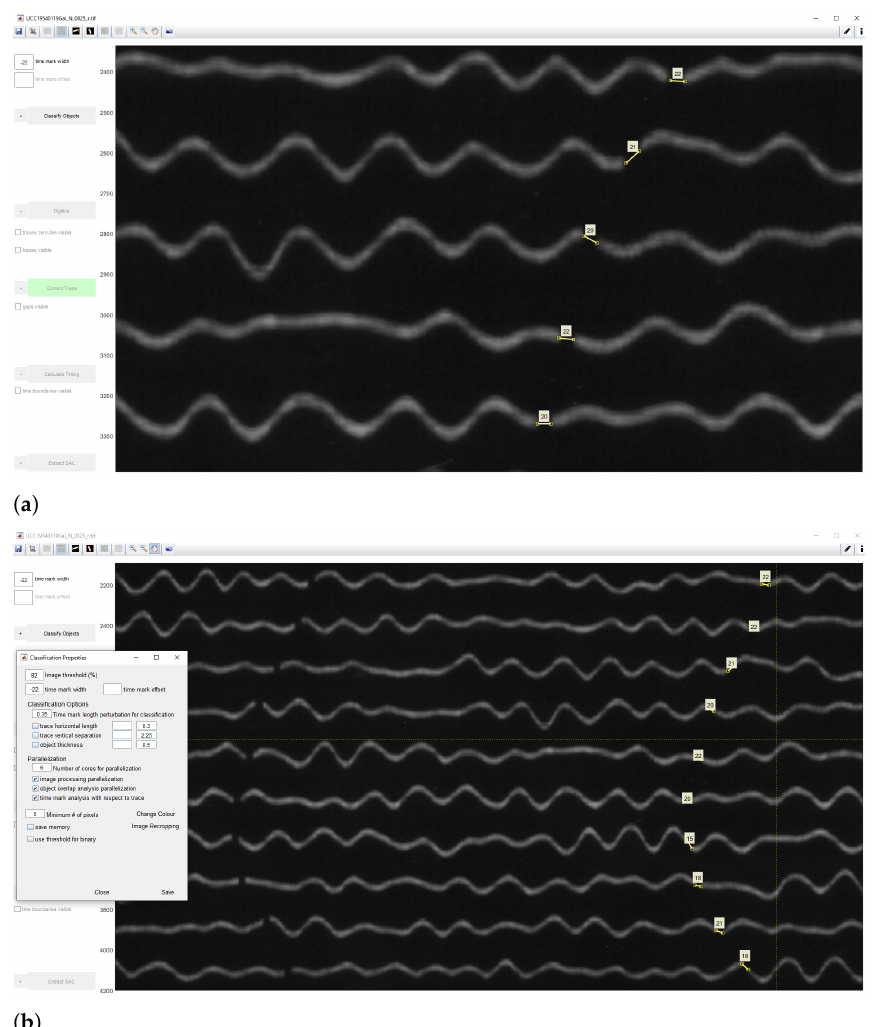
Figure 8. Classification of seismogram processed by DigitSeis. ( a ) Identifying the time marks on seismograms by measuring time gap between the records. Here: example on file UCC19540119Gal_N_0825.tif. ( b ) Indicating the time marks on seismograms as − 22 and preparing image for the